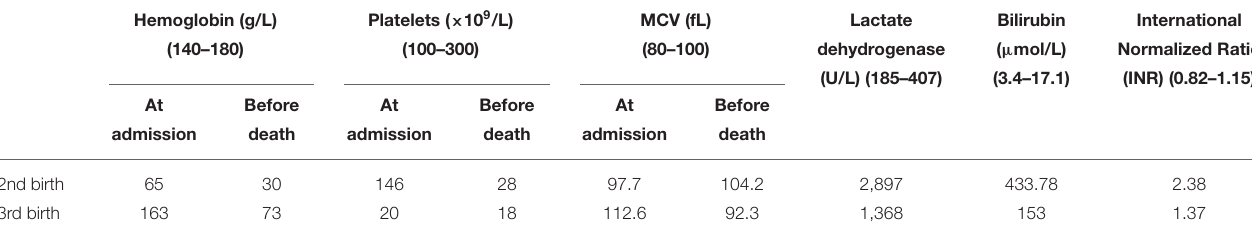
TABLE 1 | Laboratory test results for two of the live-born children of the neonatal patient’s mother. Hemoglobin (g/L)